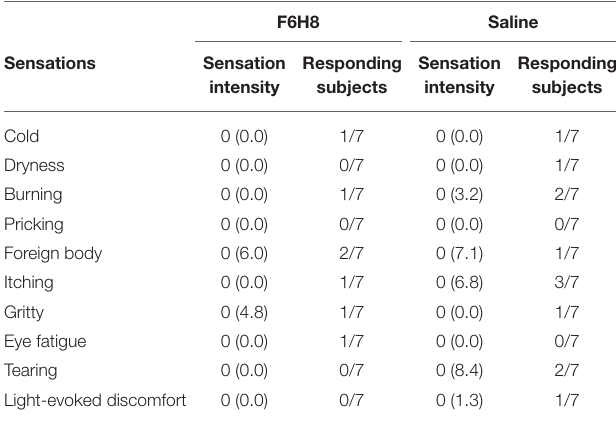
TABLE 1 | Ocular surface sensations reported 5 min after bilateral topical treatment with a 10 µ L drop of F6H8 or saline solution. Sensations Sensation